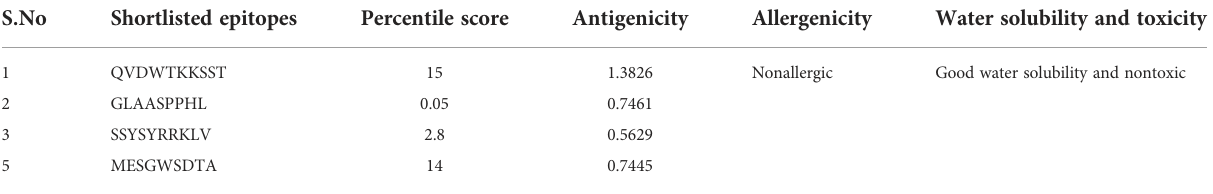
TABLE 2 Selected epitopes for vaccine construct modeling.